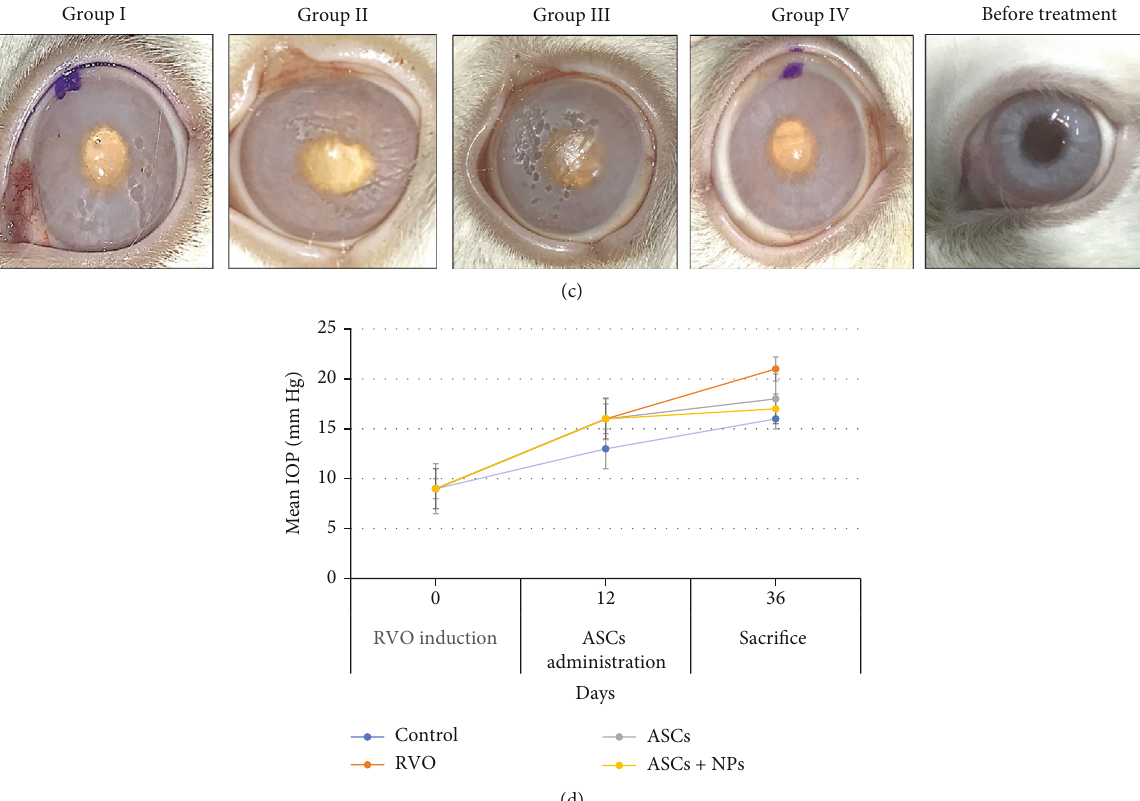
Figure 3: (a) Experimental design of the study. (b) Photo of the intravitreal injection of PD0325901 for RVO induction (day 1) (left) and of the surgery during stem cell administration (day 12) (right). (c) External photos during clinical examinations for the detection of any abnormalities in all groups and untreated eyes reveal retinal detachment in the RVO group which is limited in ASCs and especially in the ASC + NP group. (d) Evaluation of IOP in all groups shows an almost stable image after any treatment proving the safety of both RVO-animal model induction and ASC-related therapy. Data are expressed as the mean ± SD , and the IOP alterations are not statistically signi fi